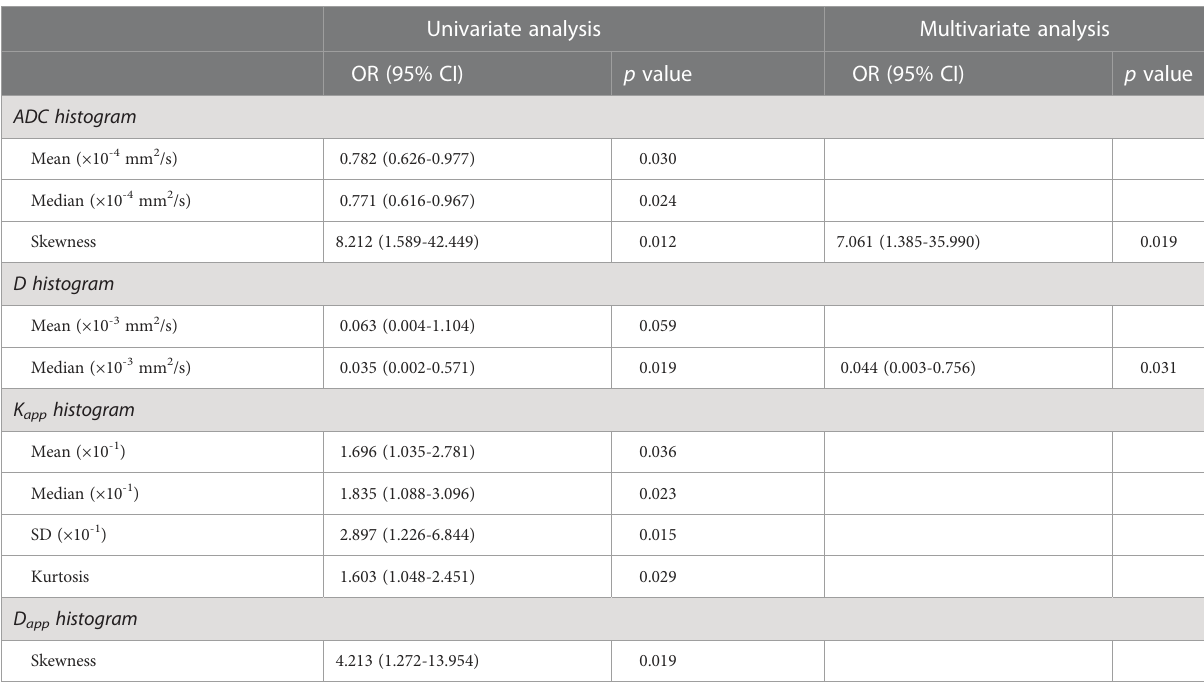
TABLE 5 Results of univariate and multivariate logistic regression